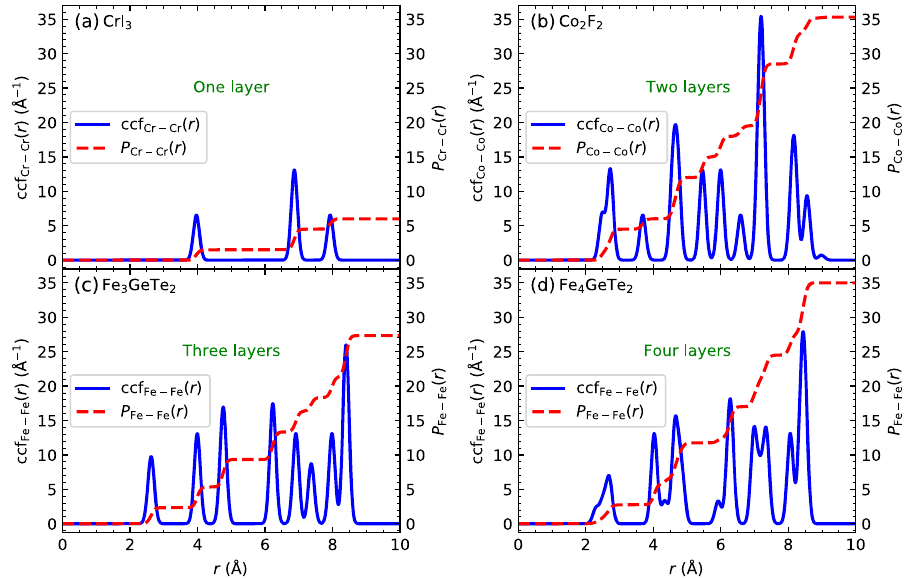
Fig. 3 The ccf ij ( r ) and their integral P ij ( r ) for a CrI 3 , b Co 2 F 2 , c Fe 3 GeTe 2 , and d Fe 4 GeTe 2